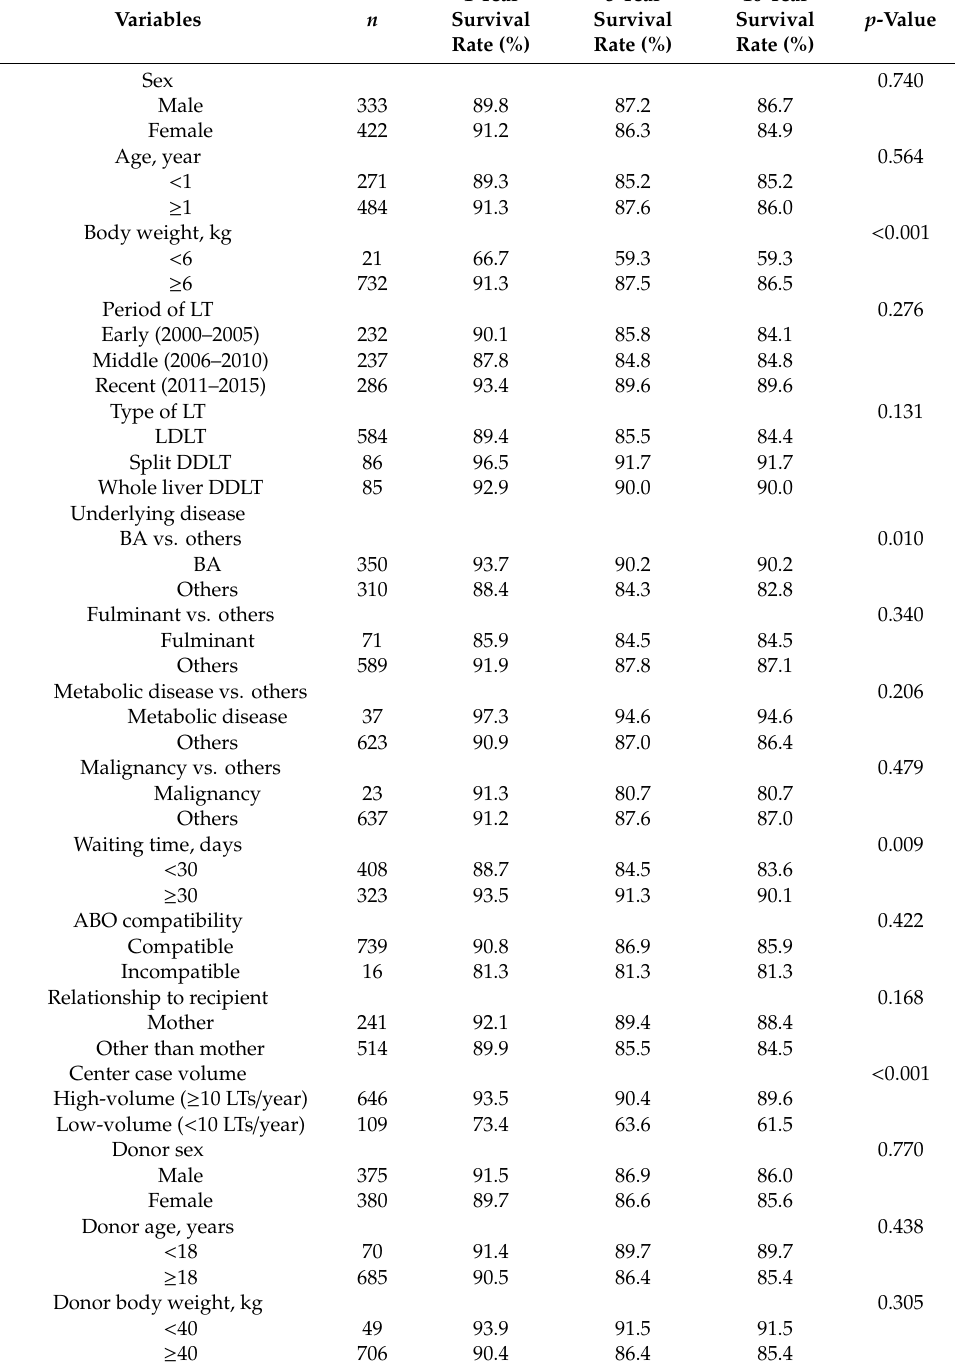
Table 2. Univariate analysis of factors associated with patient survival using the KONOS database.